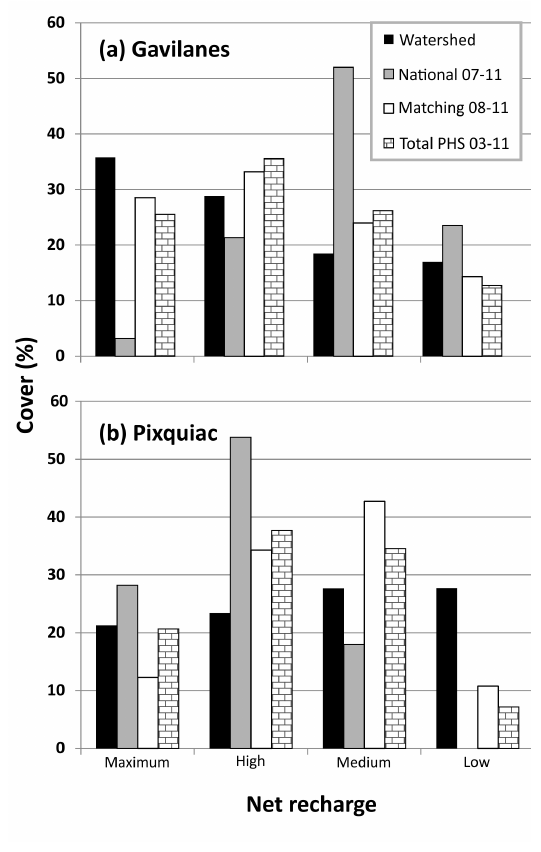
Fig. 2 . Comparison of the proportion of zones with different levels of net recharge within the Gavilanes (a) and Pixquiac (b) watersheds versus the coverage of land parcels receiving federal, local, or all types of payments for hydrologic services (PHS) during the period